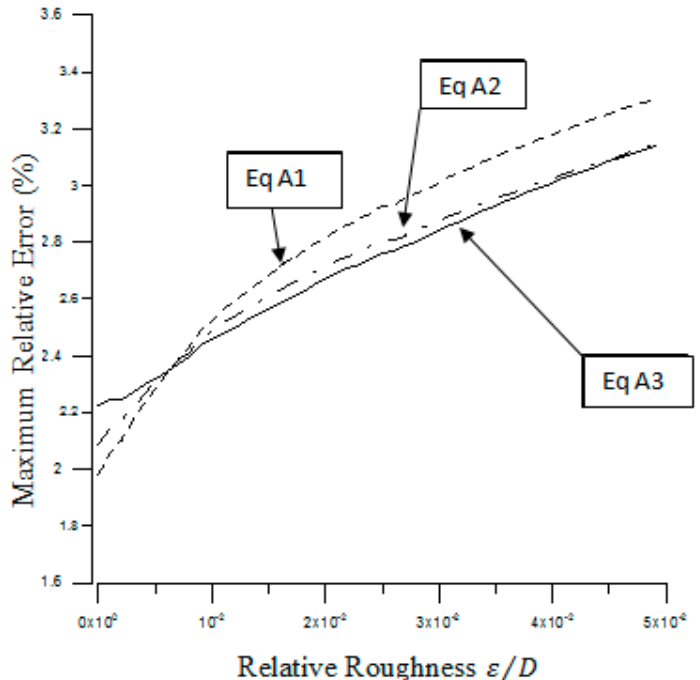
Figure 1. The maximum deviation (in percent) for versus different relative roughness. Values of Equations: 2, 3 and 4 (A1–A3) using B of Equation (2).